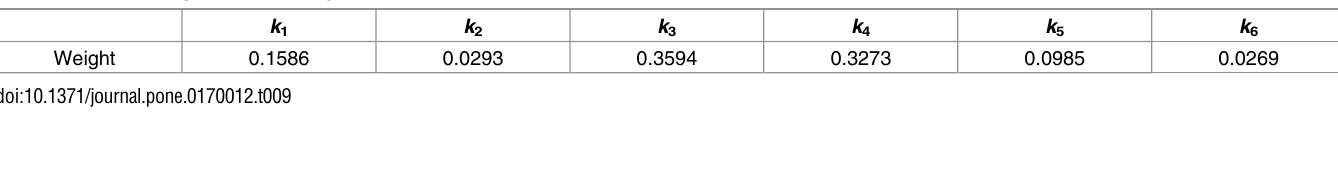
Table 9. Indices weights obtained by